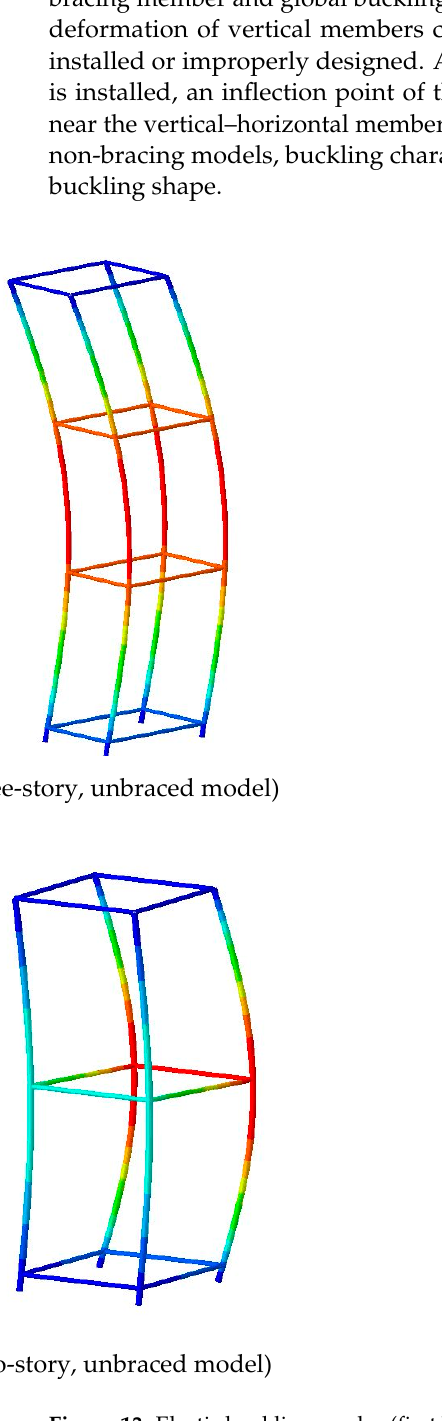
Figure 13. Elastic buckling modes (first buckling mode; rotational stiffness not considered).